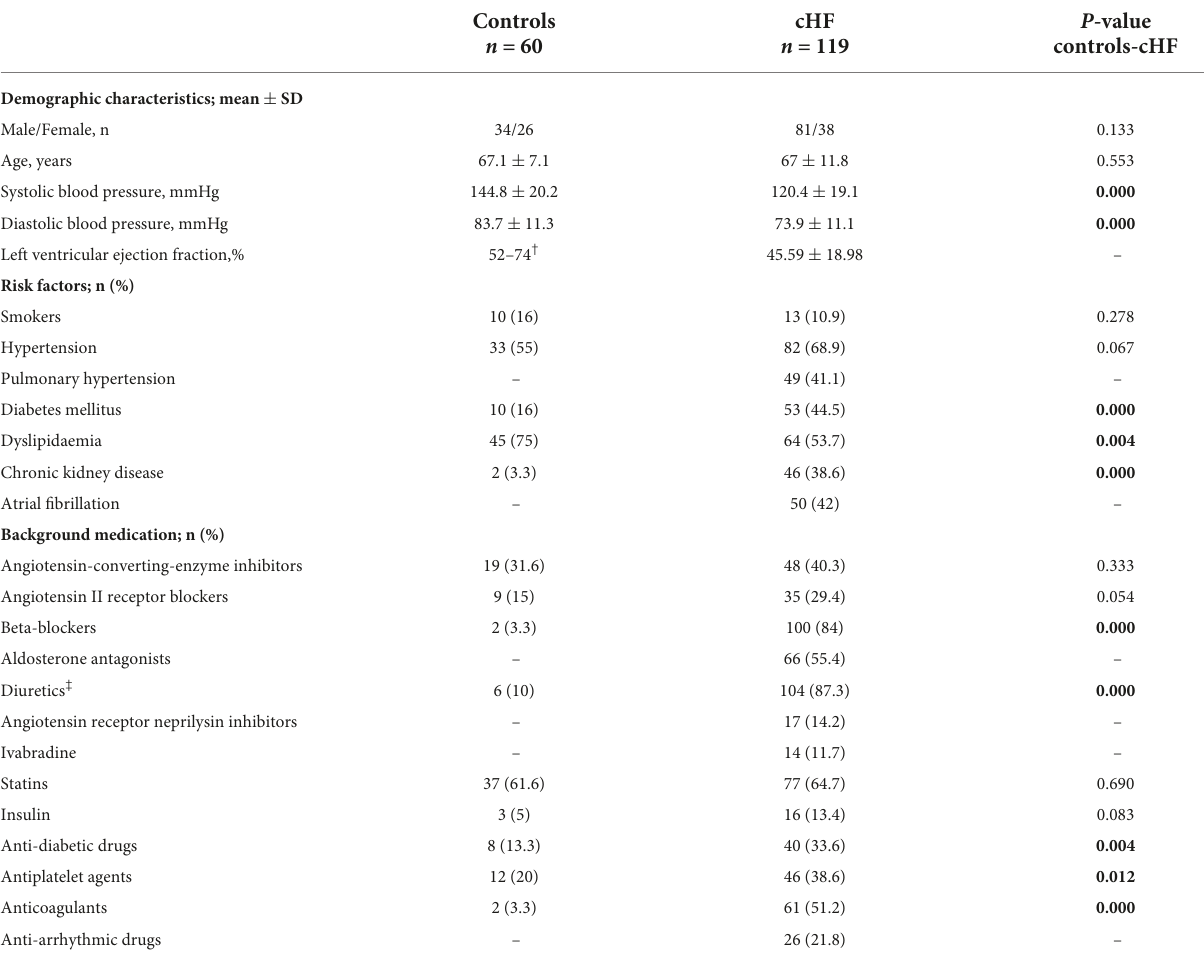
TABLE 1 Patients and controls baseline